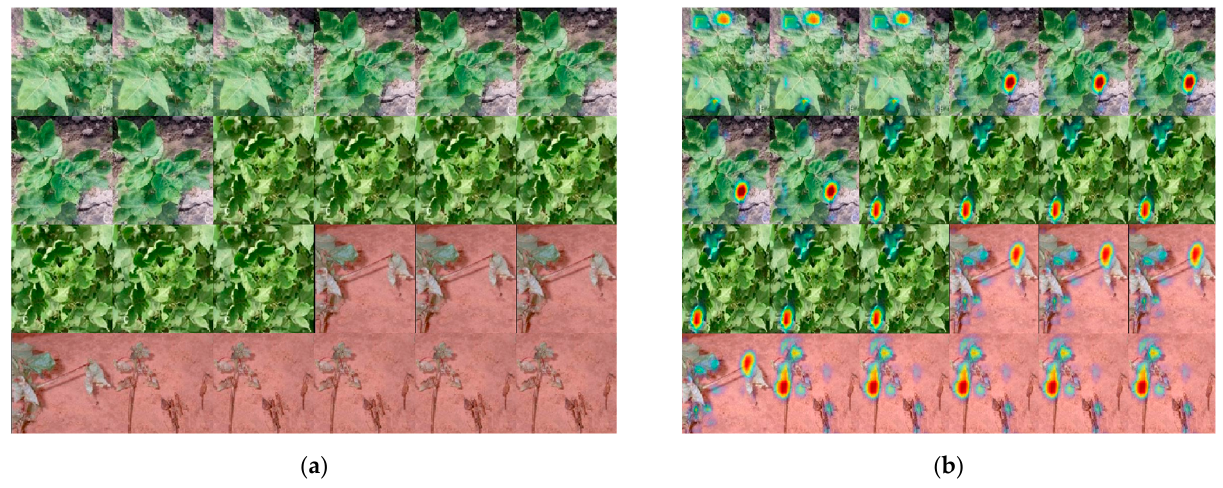
Figure 7. False-negative classification results. ( a ) Input image. ( b ) Heatmap.